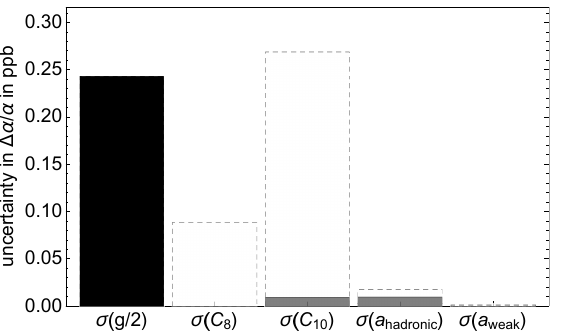
Figure 3. The uncertainty for determining α from a measured magnetic moment (solid) now comes mainly from the uncertainty in the moment after being limited for many years by theoretical uncertainty that was slightly larger (dashed).